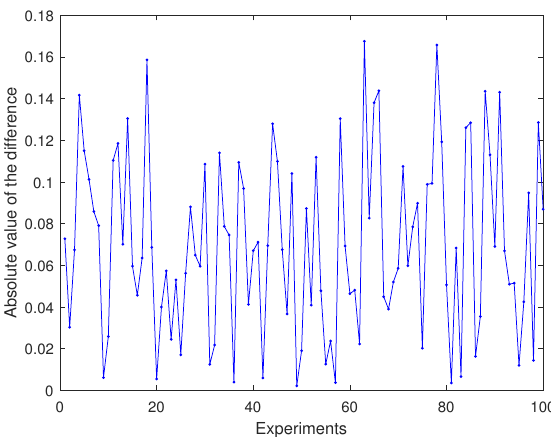
Figure 4. Log-Euclidean distance to samples.